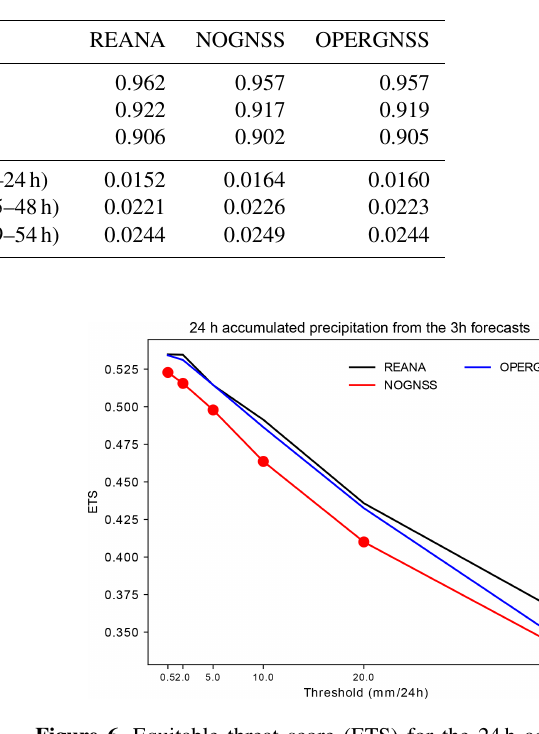
Figure 6. Equitable threat score (ETS) for the 24h accumulated precipitation from the sum of the eight 3h forecasts used as a back- ground of the data assimilation cycle each day of the period from 5 September to 5 November 2012. Results for REANA are dis- played in black; those for NOGNSS are displayed in red; and those for OPERGNSS are displayed in blue. Dots indicate that the dif- ference between the curves and the REANA curve as a reference is statistically significant at a 0.95 confidence threshold using a boot- strap